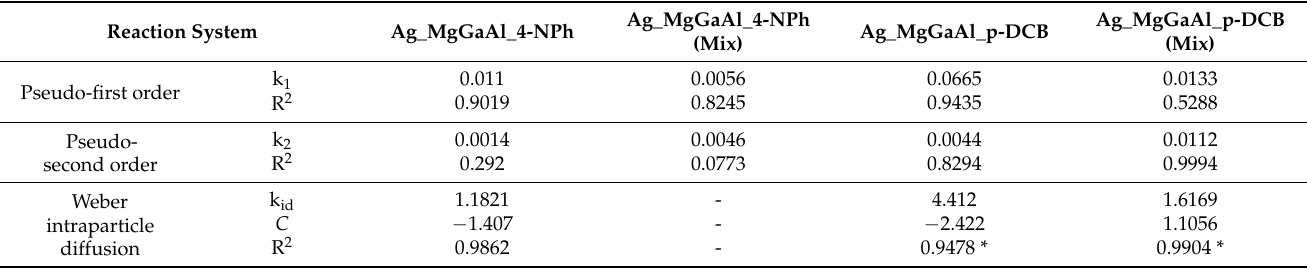
Figure 10. Kinetic analysis as fitted to: ( a ) pseudo-first order; ( b ) pseudo-second order; ( c ) Weber intraparticle diffusion; ( d ) Elovich kinetic models. Table 2. Kinetic parameters and the correlation coefficients R 2